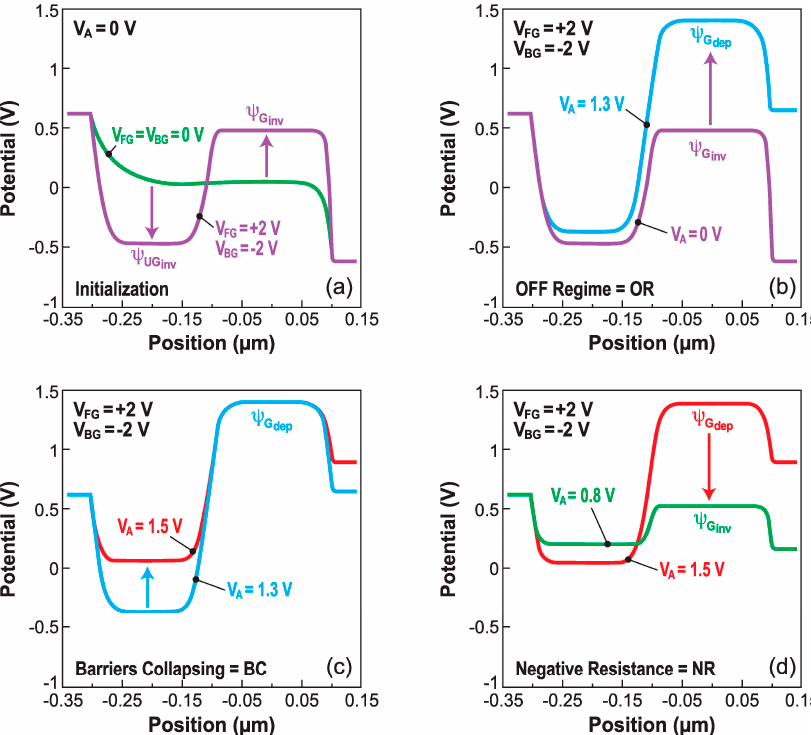
Figure 10. Electrostatic potential profiles from cathode (source) to anode (drain) during each DC operating regime: ( a ) initialization, ( b ) I OFF region, ( c ) barrier collapse, and ( d ) negative differential resistance. TCAD simulations adapted from [29].